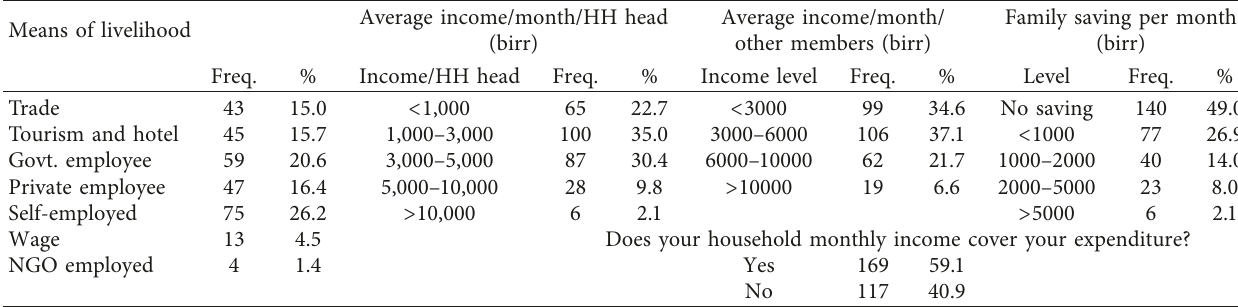
Table 3: Livelihood strategy, household income, and savings of